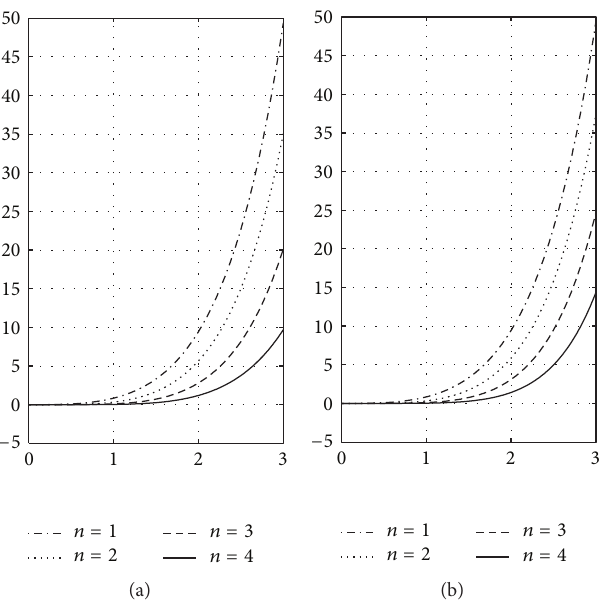
Figure 3: The error functions 𝐸 𝑛 (𝑡 𝑖 ) for Example 3: (a) present method and (b) standard